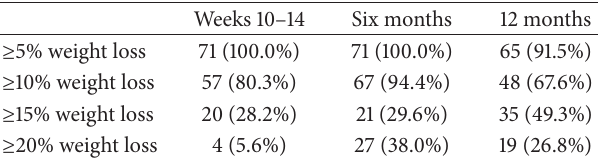
Table 4: Subjects in the ILI-group achieving ≥ 5%, 10%, 15%, and 20% weight loss from initial weight at weeks 10–14, six, and 12 months. Data are number of subjects